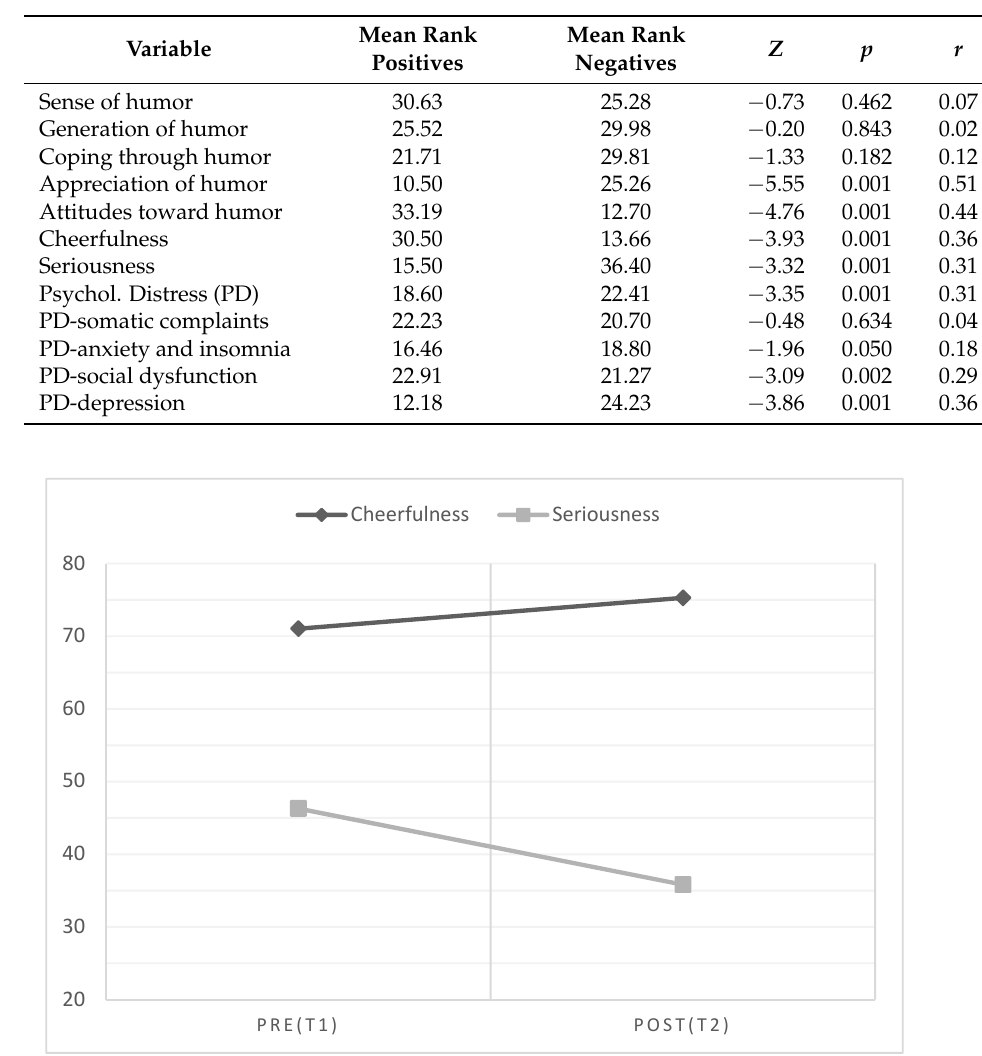
Table 3. Results from Wilcoxon Signed-Ranks tests (post–pre training measures).